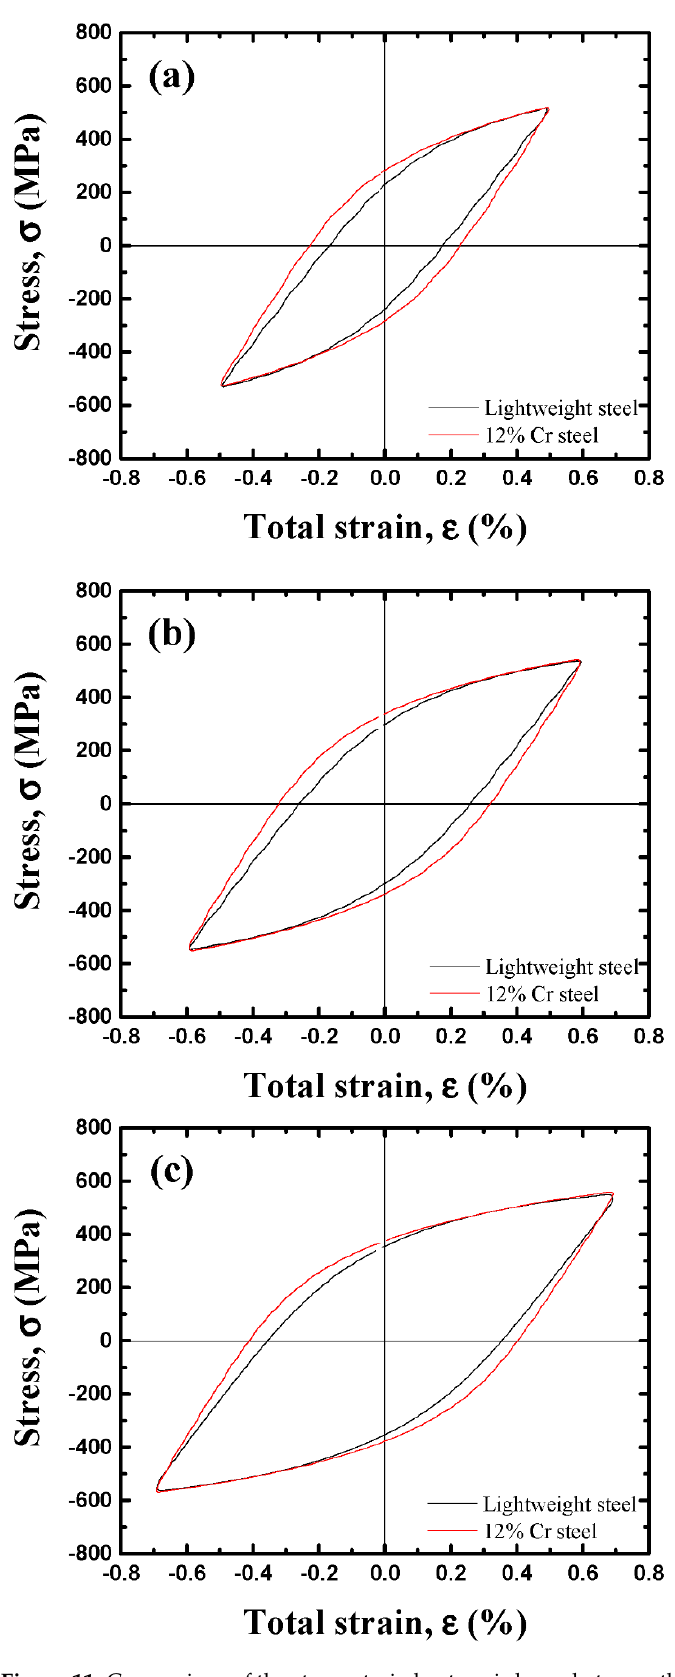
Figure 11. Comparison of the stress-strain hysteresis loops between the lightweight and 12% Cr steels for the half-life cycle at the total strain amplitudes of ( a ) 0.5, ( b ) 0.6, and ( c ) 0.7%.